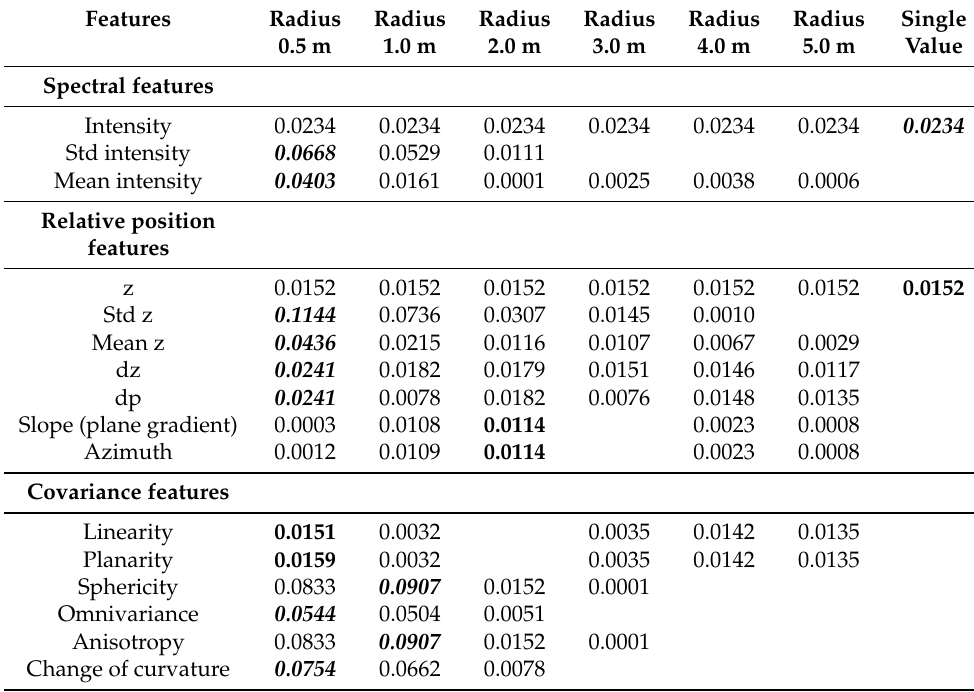
Table 7. Predictors from all boulders with positive weight calculated from relief-F